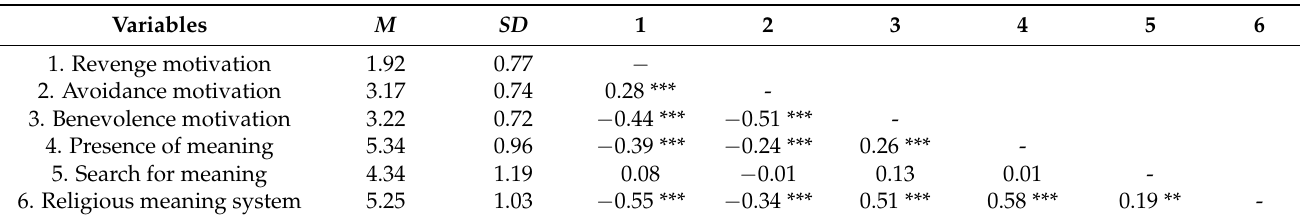
Table 1. Descriptive statistics and correlations among interpersonal forgiveness, meaning in life, and the religious meaning system.